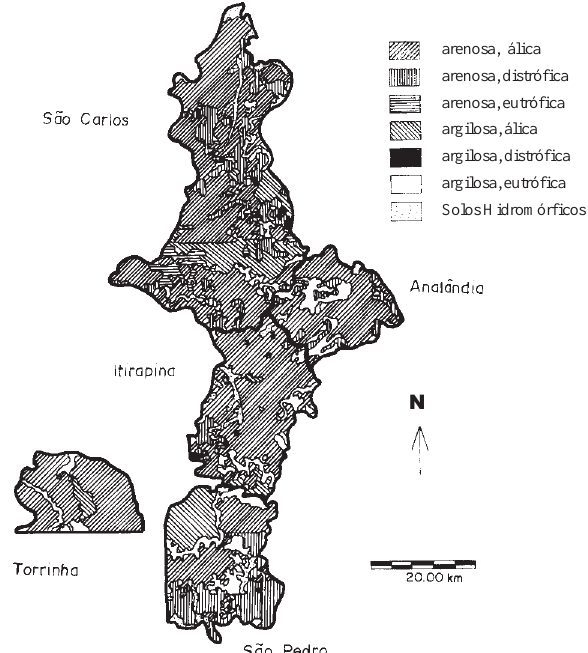
Figura 2 . Zonas Edáficas da Zona Agroecoadminis- trativa de São